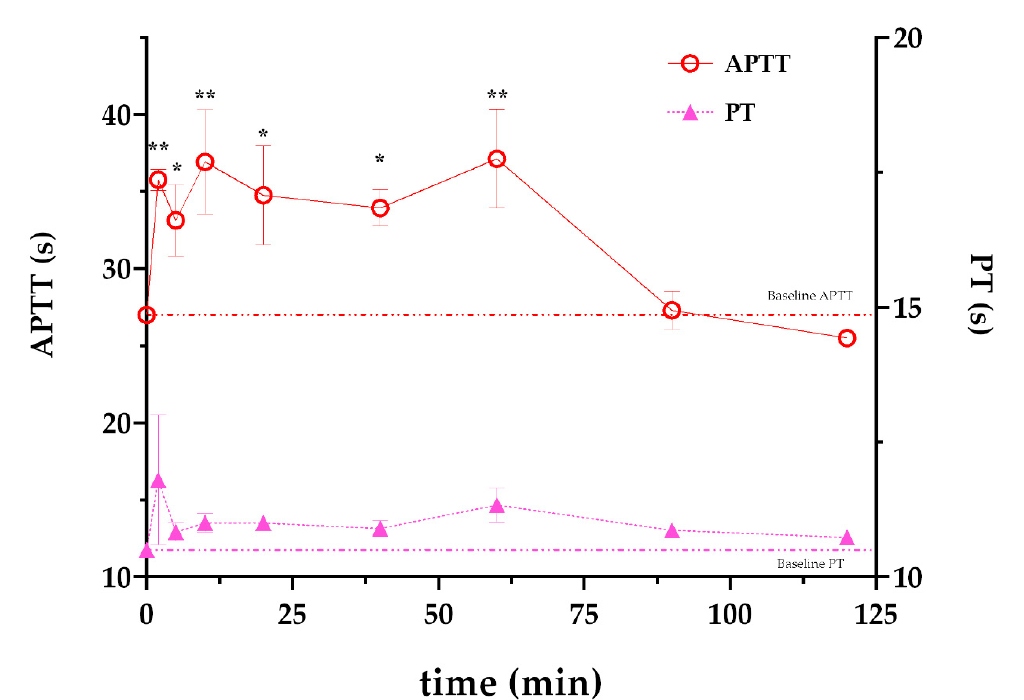
Figure 3. Time course anticoagulant effect of rFasxiator N17R, L19E in rats . Activated partial thrombo ‐ plastin time (APTT, red open circles, left Y ‐ axis) and prothrombin time (PT, pink solid triangles, right Y ‐ axis) of rat plasma collected at 2, 5, 10, 20, 40, 60, 90, and 120 min after a single i.v. bolus injection of rFasxiator N17R, L19E ( n = 3). Baseline APTT and PT (time = 0 min) are plotted as red and pink dotted lines, respectively. ** indicates that p ≤ 0.01; * indicates that p ≤ 0.05.